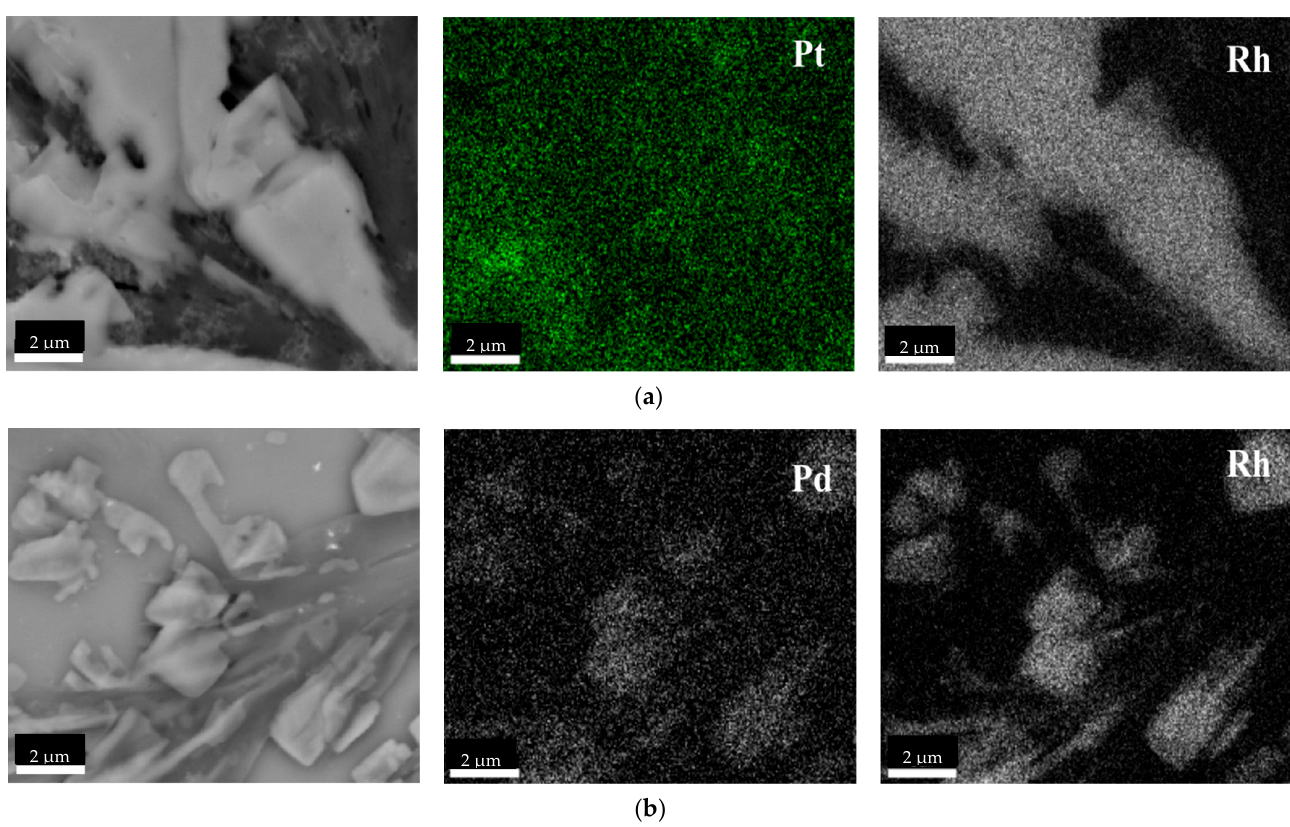
Figure 7. Scanning electron microscopy (SEM) coupled with EDS images of ( a ) Pt/Rh-NP and ( b ) Pd/Rh-NP (the molar ratio of PGM:PVP:reducer was 1:1:1) using NaBH 4 .